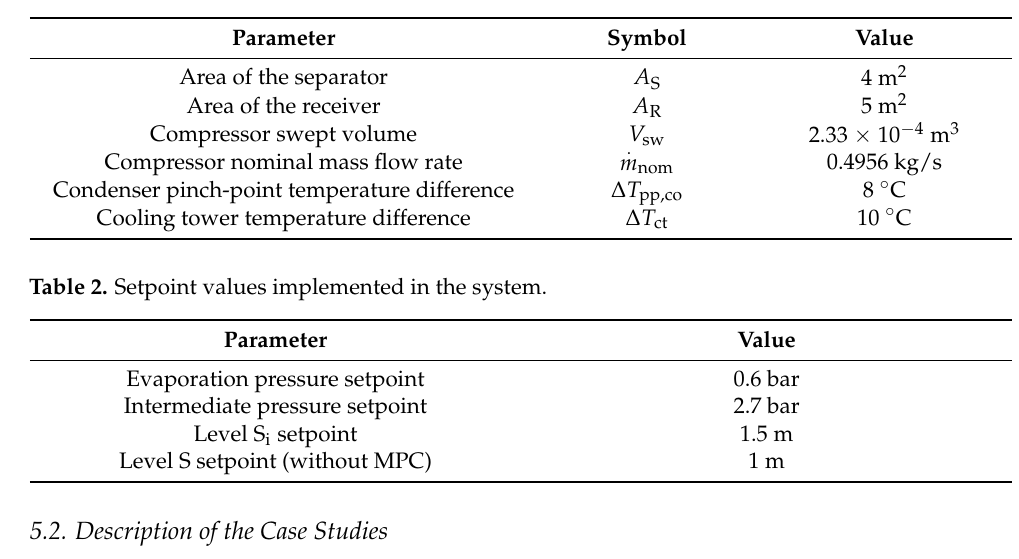
Table 1. Main parameters of the digital twin model. The compressors C b and C a as well as the two separators S and S i have the same size.